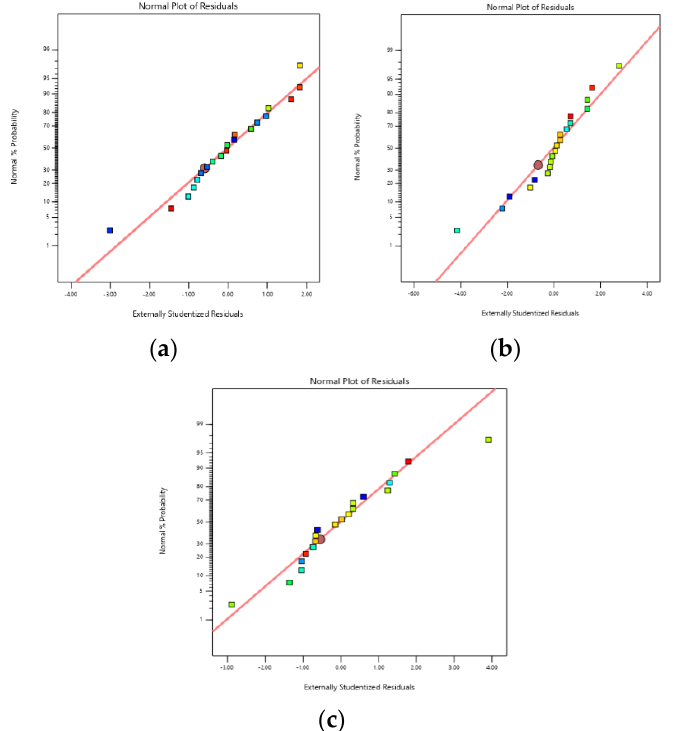
Figure 2. Normal plot of residuals for ( a ) biomass, ( b ) COD removal efficiency, and ( c ) power density generation.